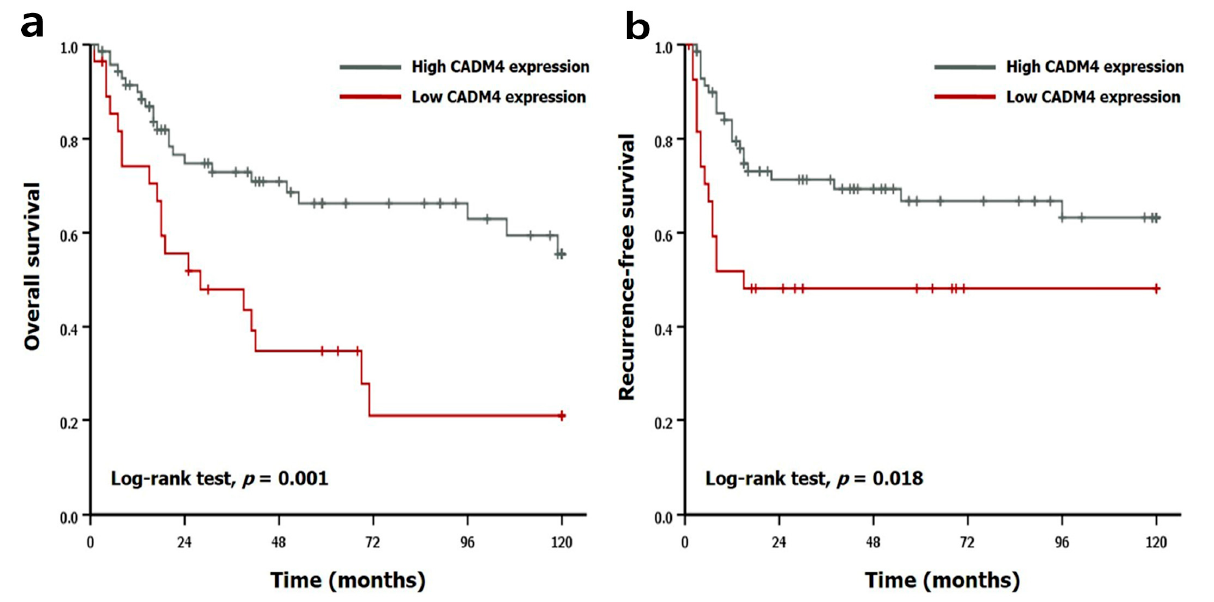
Figure 1. Survival analyses using Kaplan–Meier method in patients with gallbladder cancer (GBC). ( a ) Overall survival (OS; log-rank test, p -value: 0.001). ( b ) Recurrence-free survival (RFS; log-rank test, p -value: 0.018).